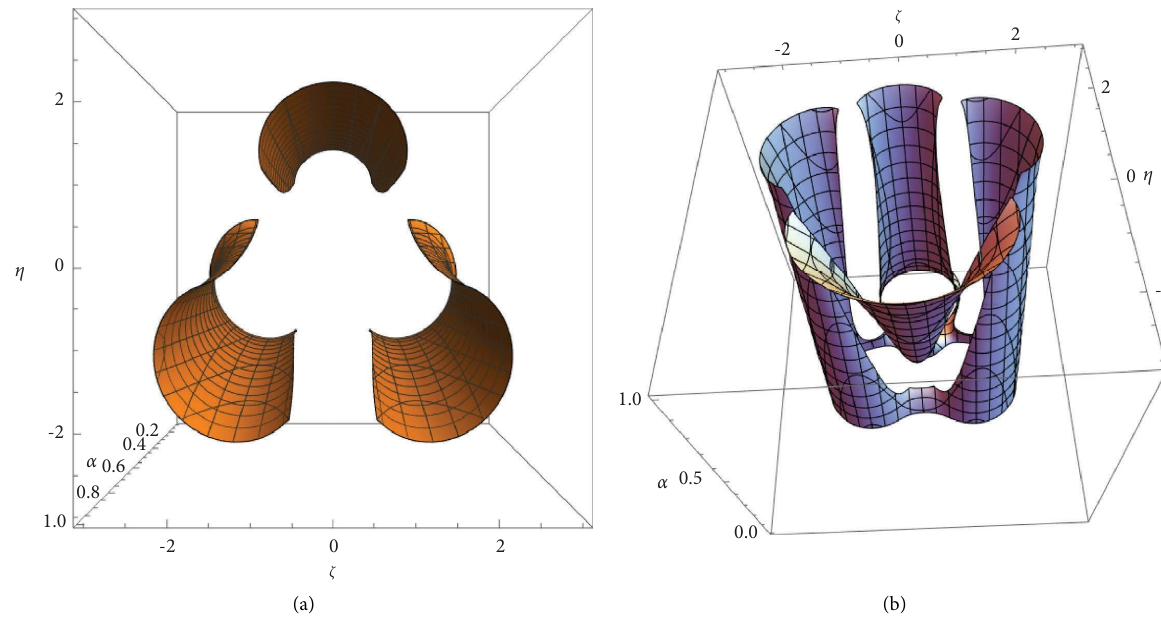
Figure 21: Stability regions (a) case II and (b) case